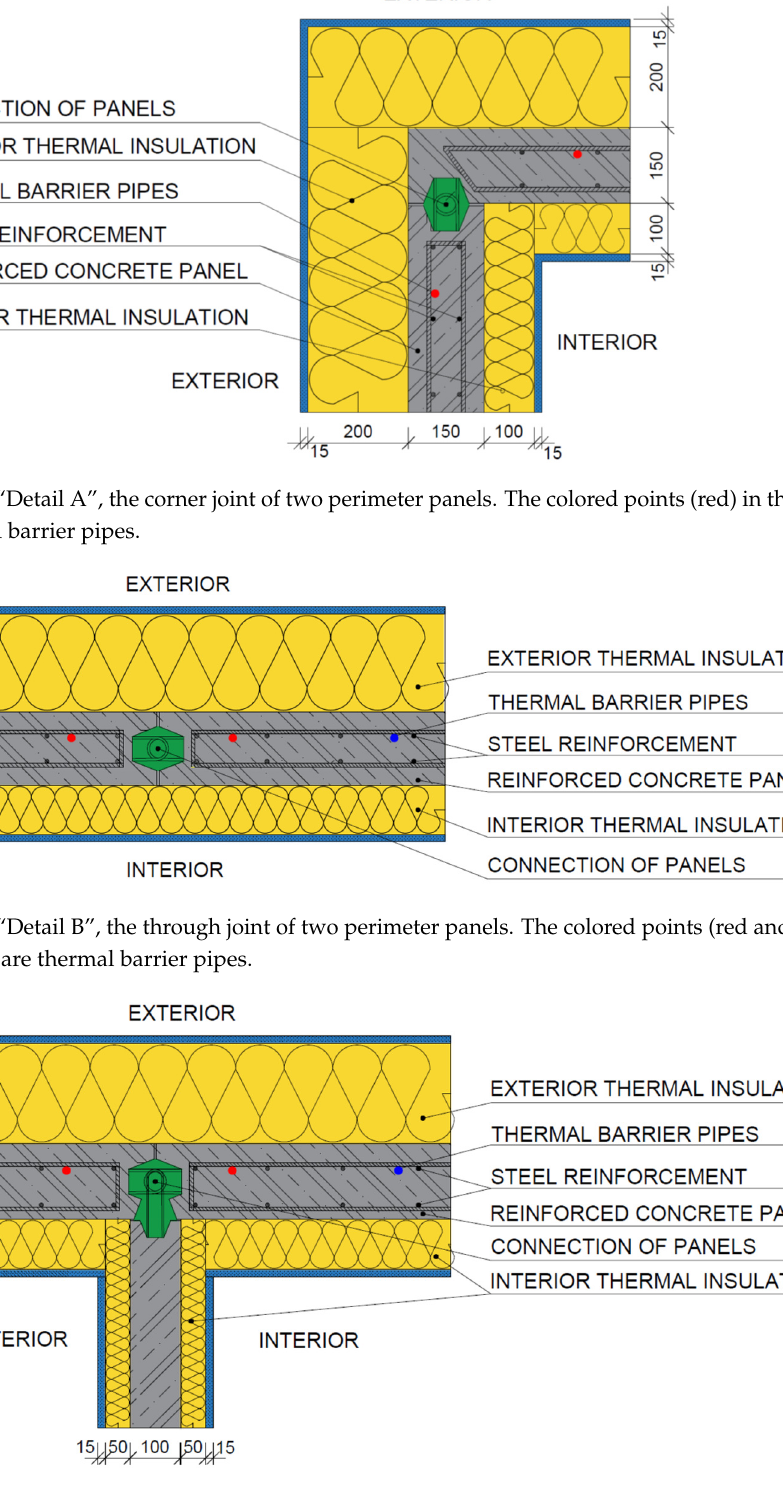
Figure 13. “ Detail C”, a through joint of two perimeter panels with an internal load-bearing panel. The colored points (red and blue) in the picture are thermal barrier pipes.